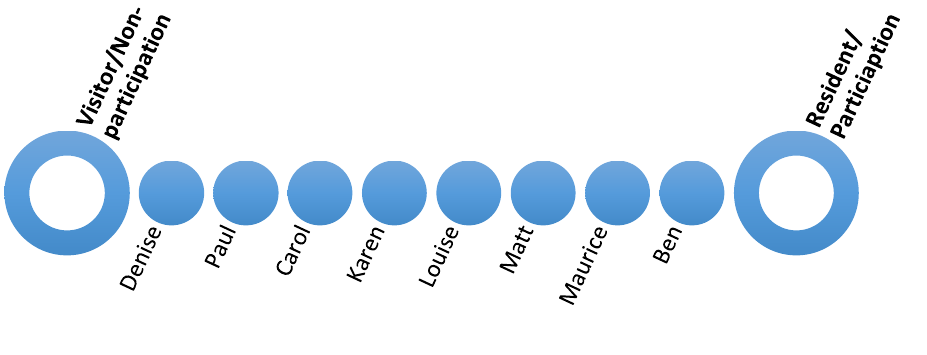
Figure 1 - Participant cases mapped to the Visitor-Resident continuum While the Visitor-Resident mapping process was useful for highlighting similarities and differences in activities of participants on Twitter, Wenger’s (1998) modes of participation was used to problematise various types of online participation. Non-participation or peripheral participation were matched with Visitor attributes while richer participation on Twitter matched with Resident attributes. Rather than report on data from all cases, three of the eight participants are highlighted in this paper. These participants Denise, Louise, and Ben demonstrated various levels of engagement with Twitter and are presented here to show the significant differences in Twitter participation within the research